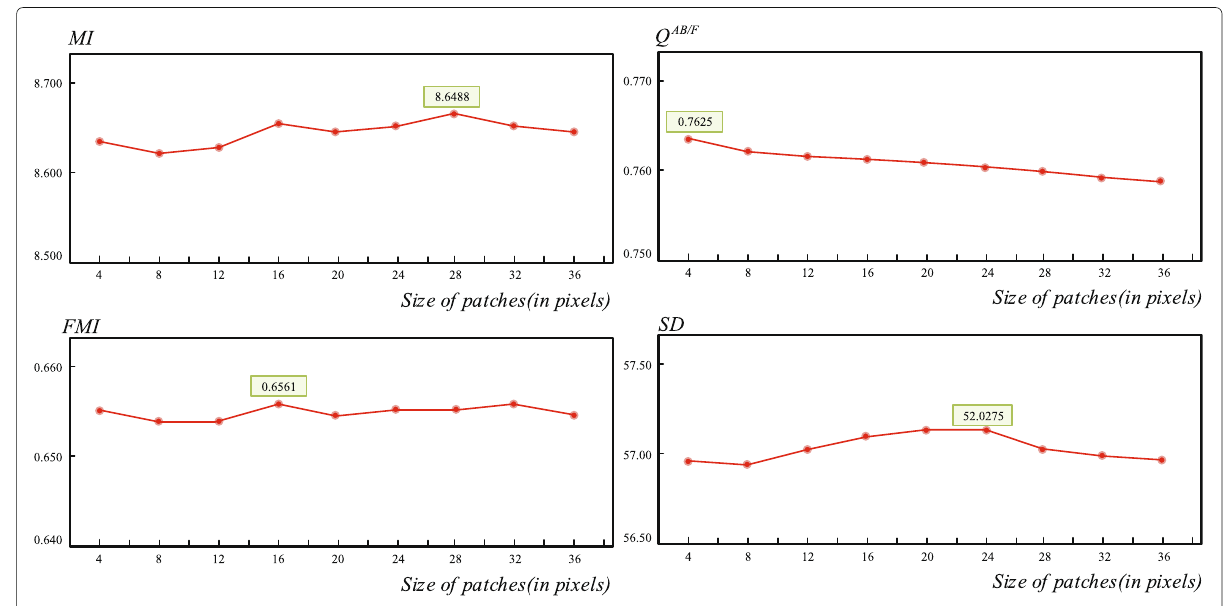
Fig. 11 The influence of patch size on four metrics. The size of the image block corresponds to the amount of information contained. Too-large patch sizes are usually resulting in inaccurate classification. Too-small patch sizes increase the time cost of the experiments. We obtained the optimal parameters by verifying different patch